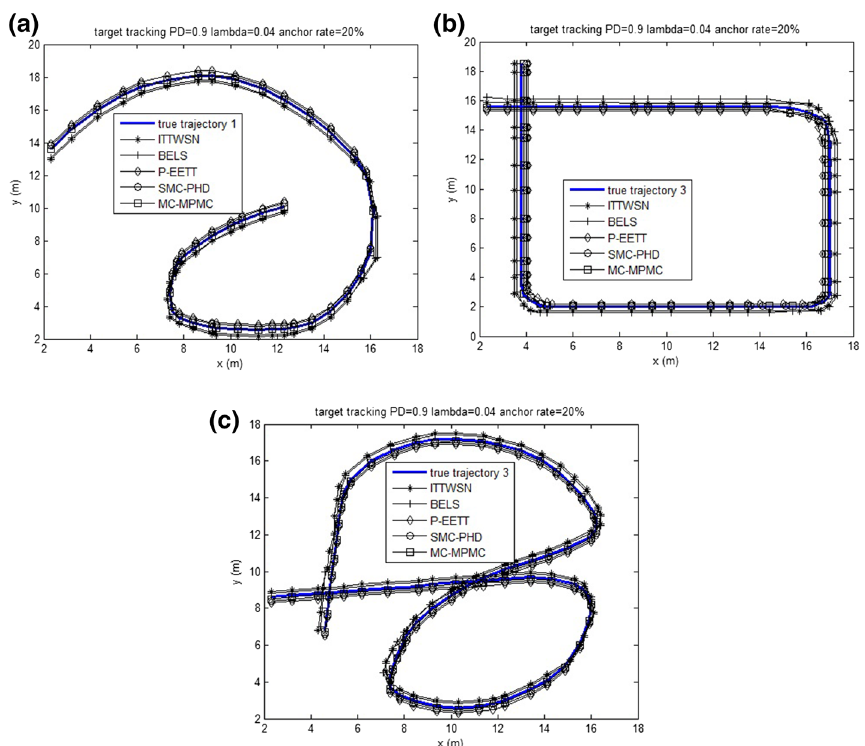
Fig. 7 Maneuvering trajectory tracking comparisons for a single target